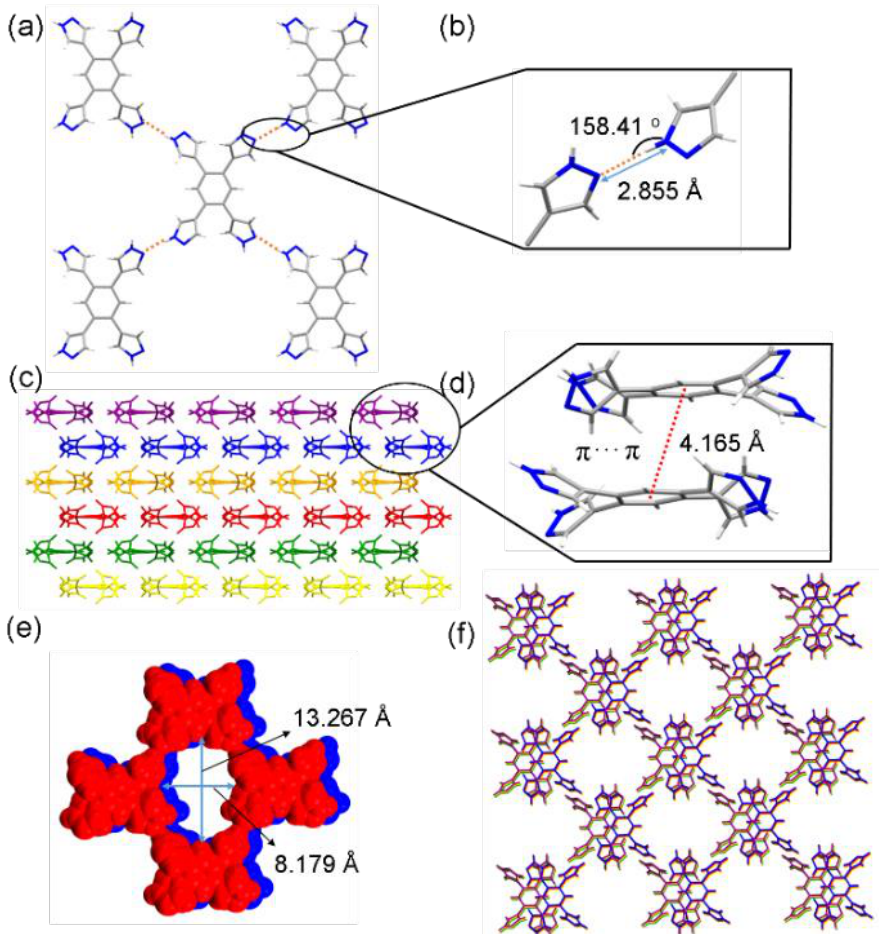
Figure 1. Crystal structure of HOF-1 . ( a ) View of the structure and the connection of adjacent building blocks. ( b ) Hydrogen-bond length and angle. ( c ) The stacking of 2D layers. ( d ) π ··· π interactions. ( e ) One-dimensional (1D) channels. ( f ) Representation of the porous framework.